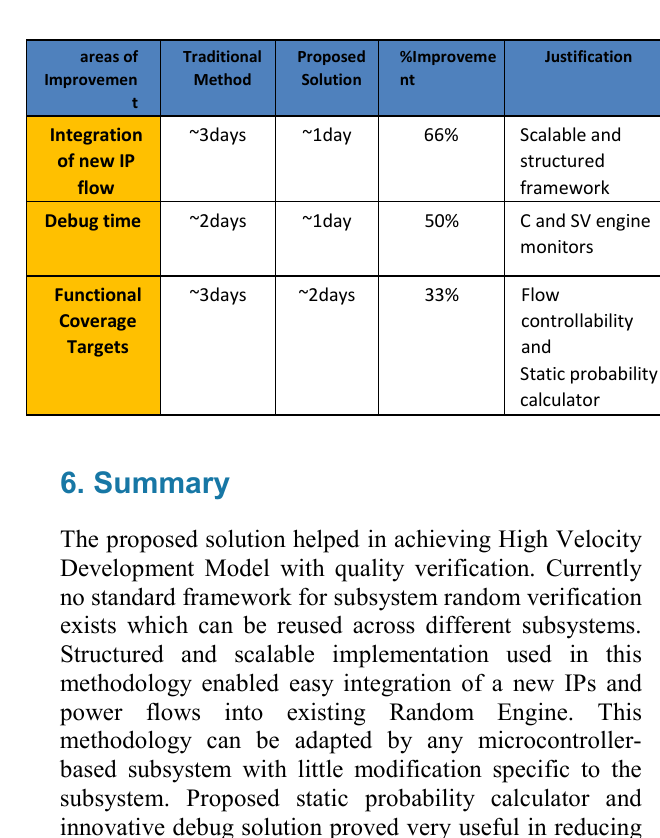
Table 1. Improvements achieved with proposed